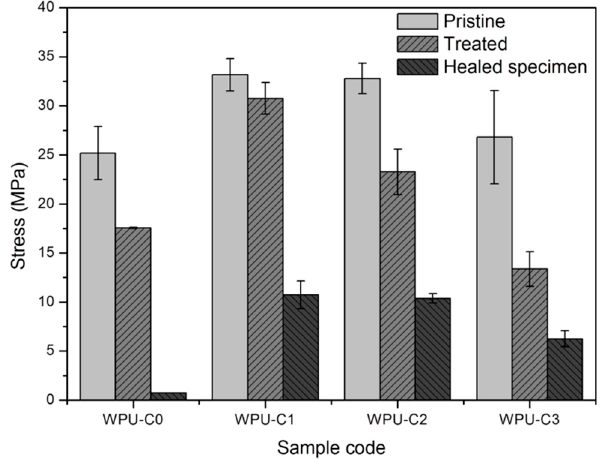
Figure 6. The mechanical properties of different WPUs after the cut-and-heal tests by the heat treatments of pristine specimens.